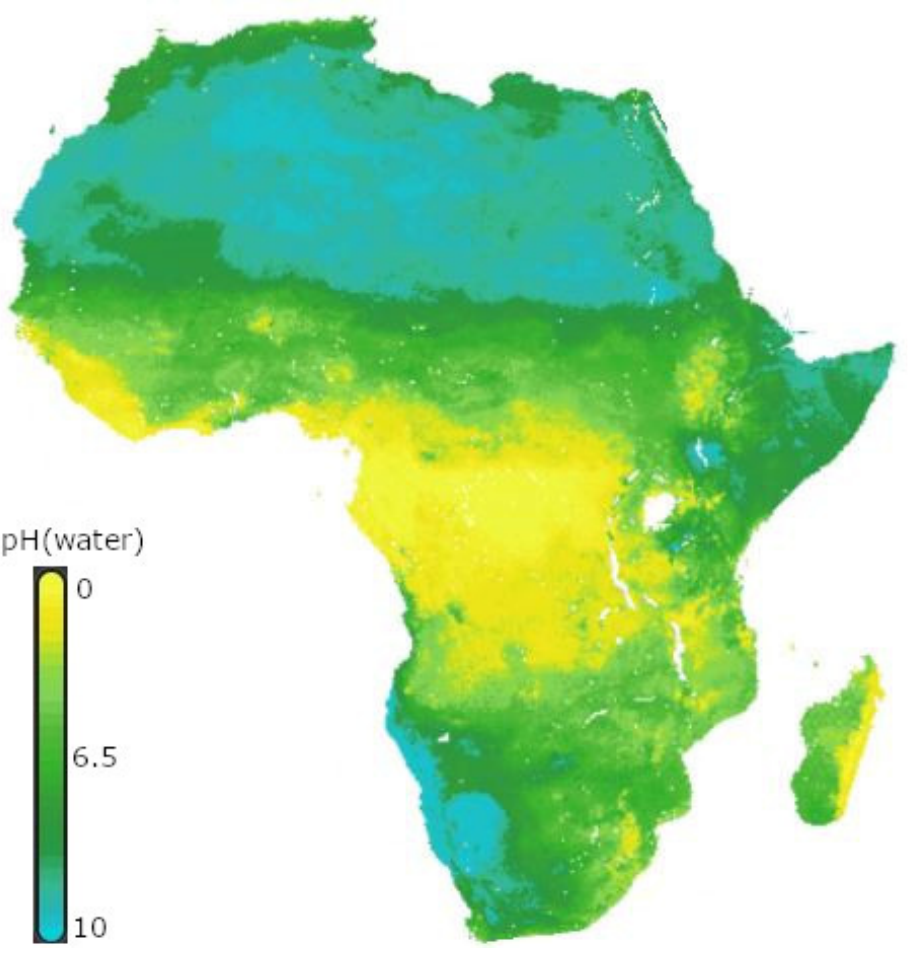
Figure 4. Soil pH in Africa Africa